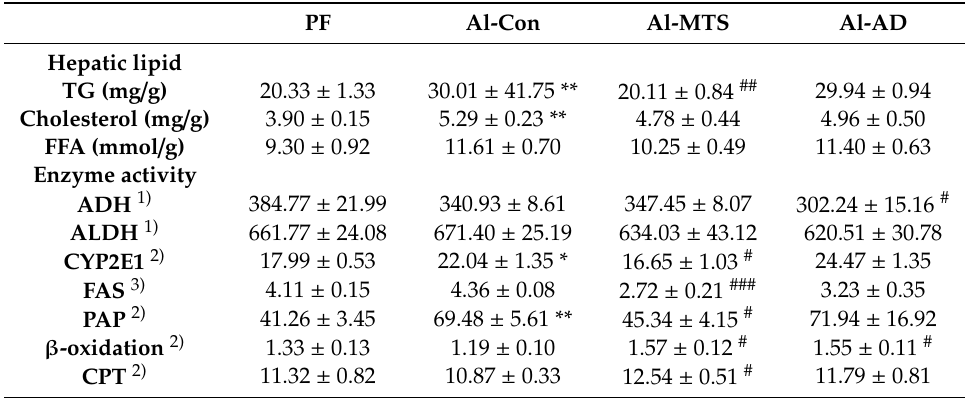
Figure 3. E ff ect of methoxsalen supplementation on hepatic hematoxylin and eosin and Masson’s Trichrome staining in chronic alcohol-fed rats. Magnification 400 × ; the yellow arrows indicate lipid droplets and inflammation. Table 2. E ff ects of methoxsalen supplementation on hepatic lipid contents and metabolic enzyme activities in chronic alcohol-fed